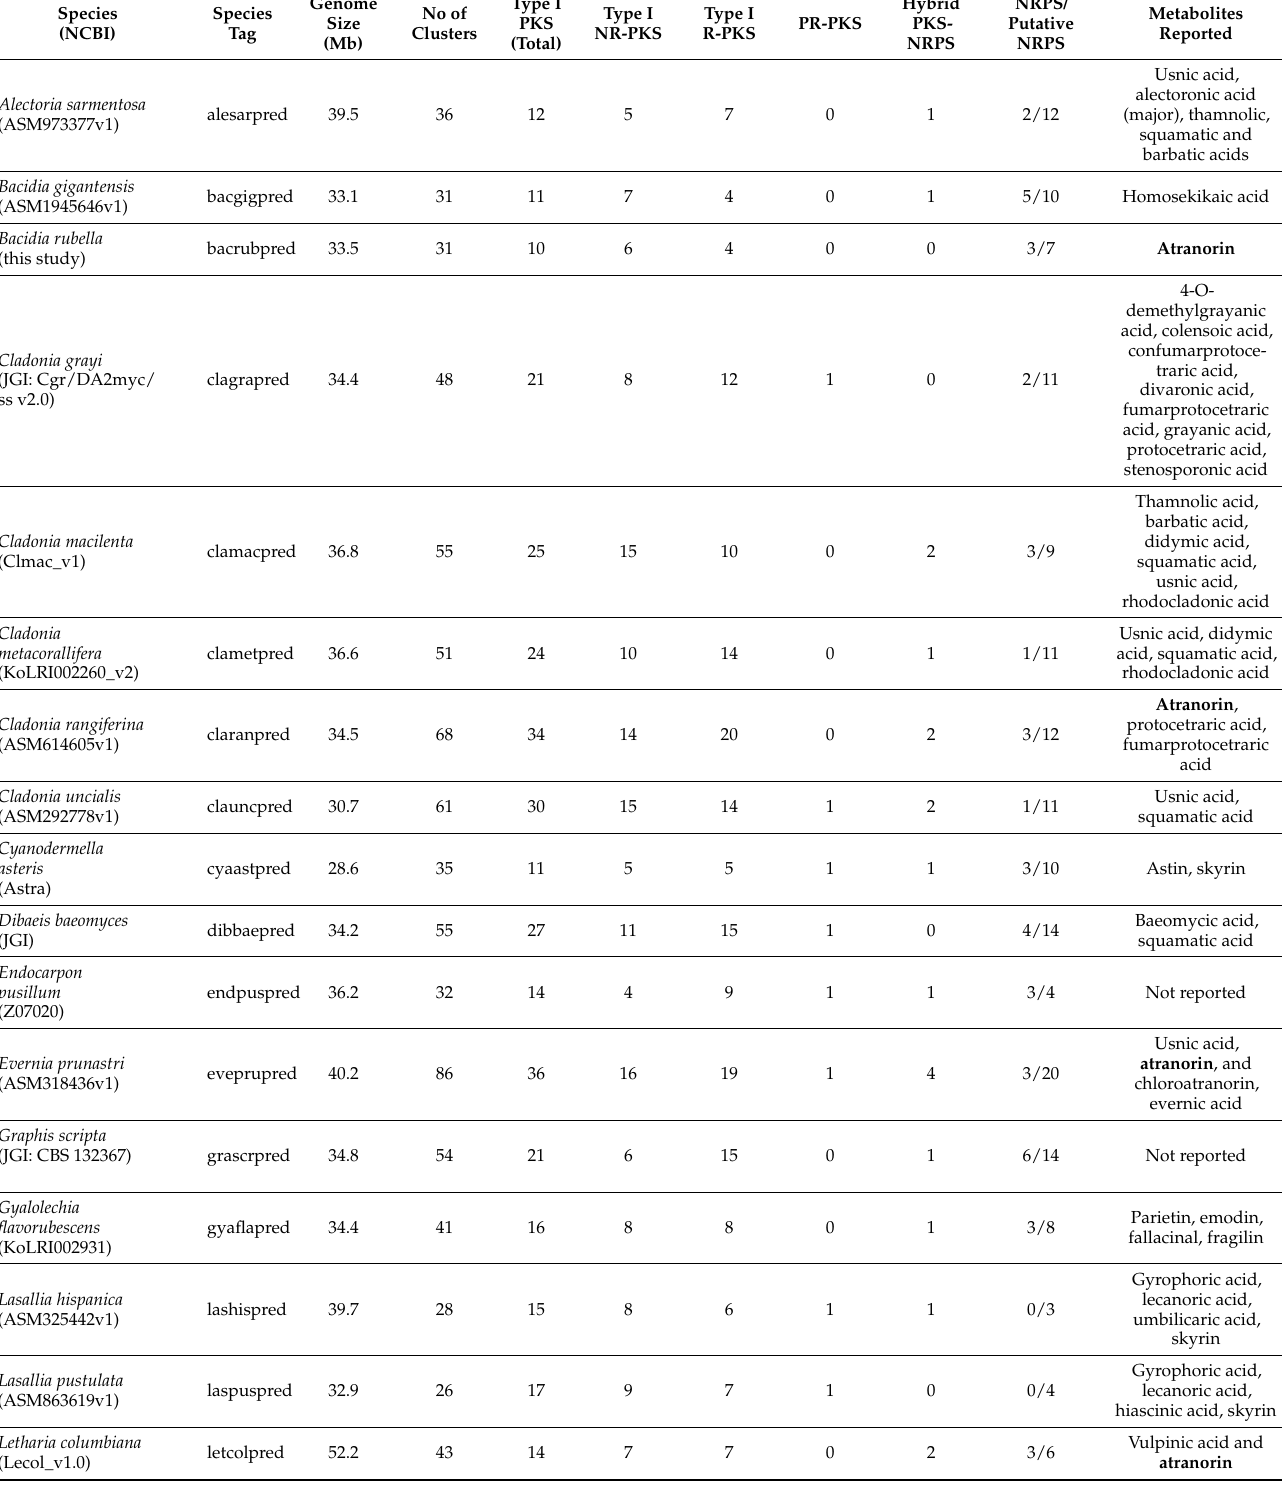
Table 2. Overview of biosynthetic gene clusters and polyketide synthase families found in the twenty-three studied fungal genomes. The occurrence of the major secondary substance of B. rubella , atranorin, is highlighted. All sequences except the de novo sequenced B. rubella genome are from NCBI, if not otherwise specified in the first